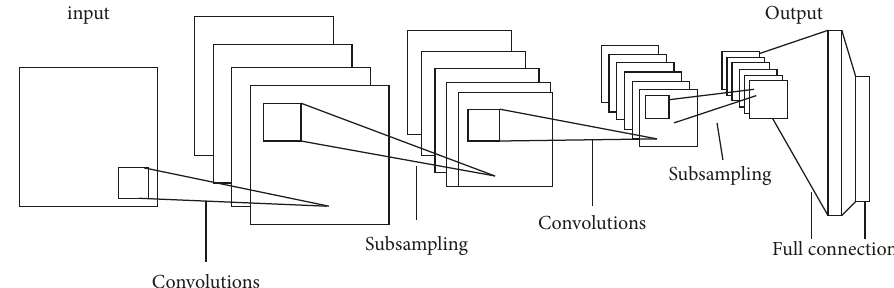
Figure 3: Convolutional neural network